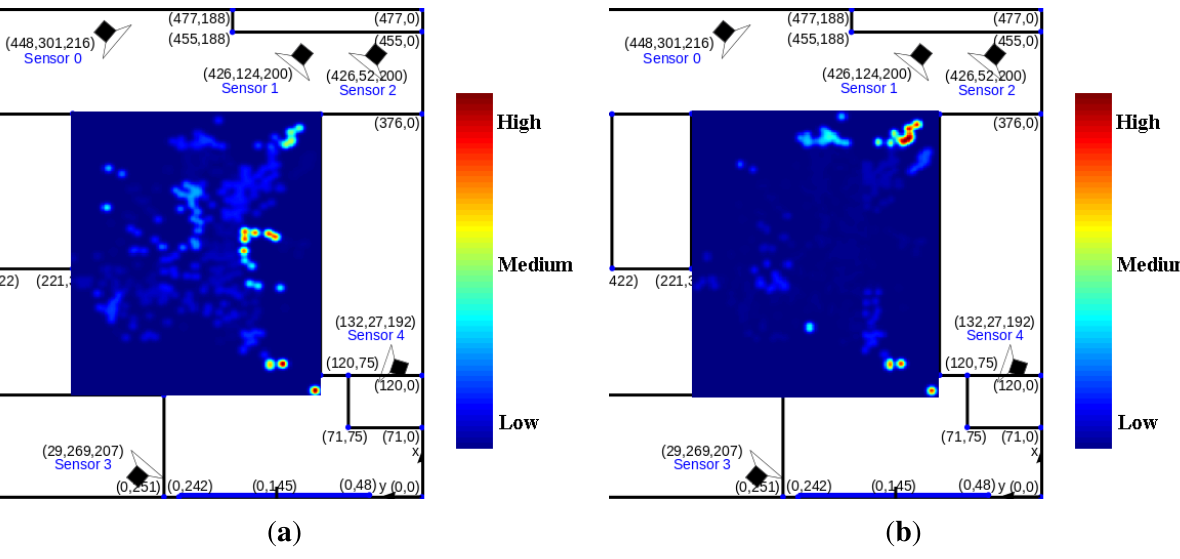
Figure 13. ( a ) Error map between average speed map of trajectories from our proposed tracker (RML) and UWB, and ( b ) Average TATE map of our proposed